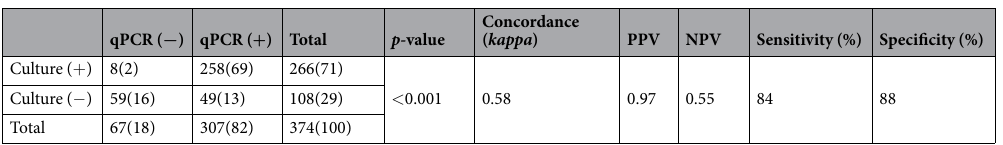
Table 1. Yield of culture and molecular qPCR for the detection Streptococcus pneumoniae in nasopharyngeal swabs (n = 374). Numbers are value (%), p -values of < 0.05 were considered significant. PPV, positive predictive value. NPV, negative predictive